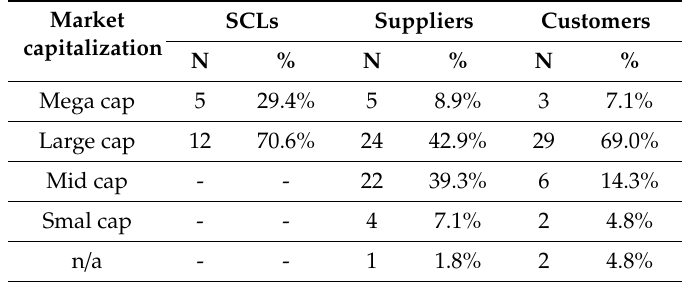
Table A5. Distribution of central sample firms per market capitalization category.